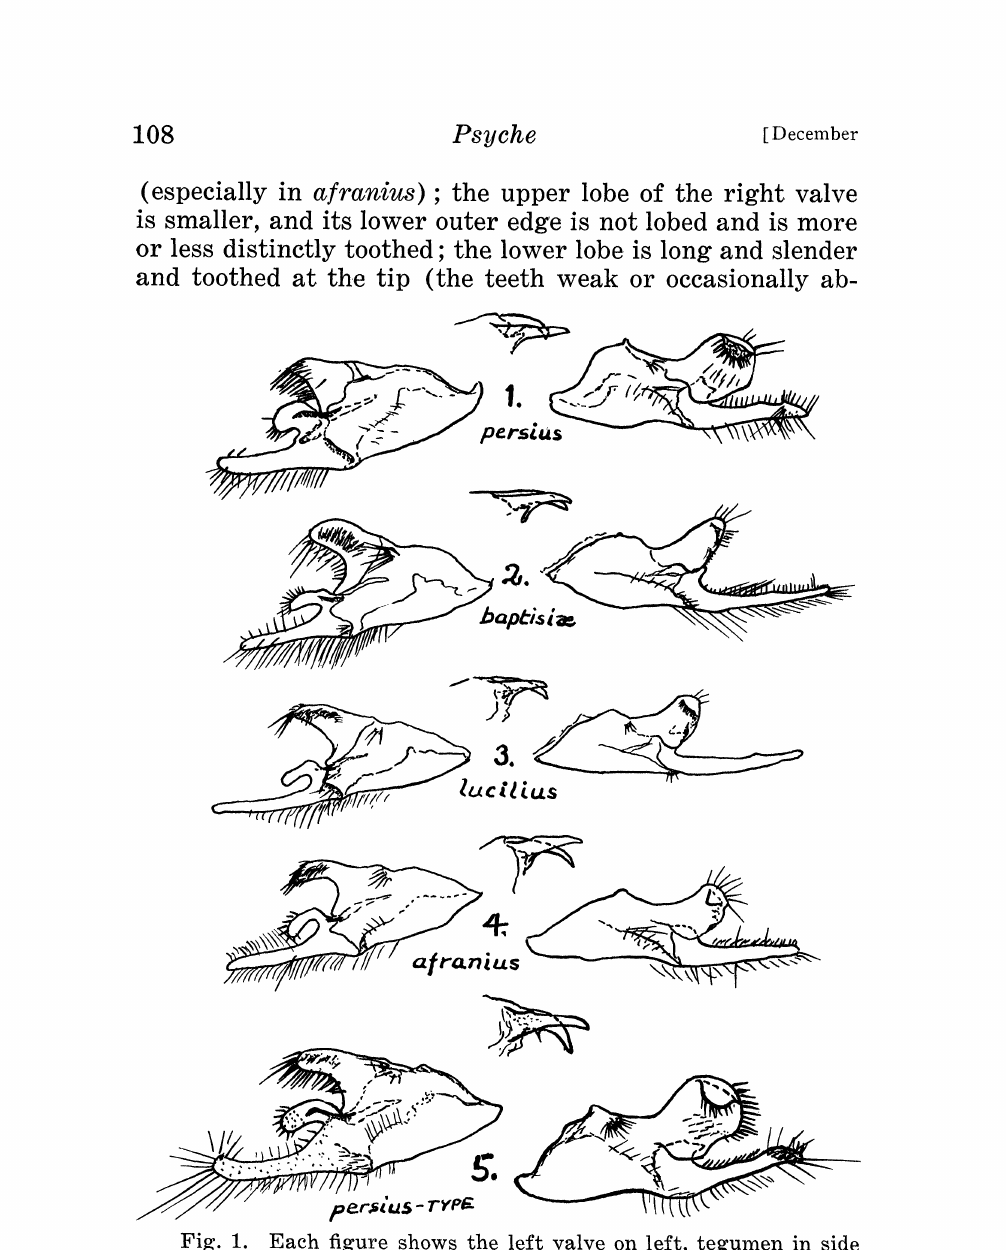
Fig. 1. Each figure shows the let valve on left, tegumen in side view in the center, and right valve at right. 1, T. persius, Bristol, R. I. 2, T. baptisi, type, Woods Hole, Mass.; 3, T. luci:lius, Ithaca, N. Y.; 4, T. afranius, Ariz.; 5, T. persius, type,